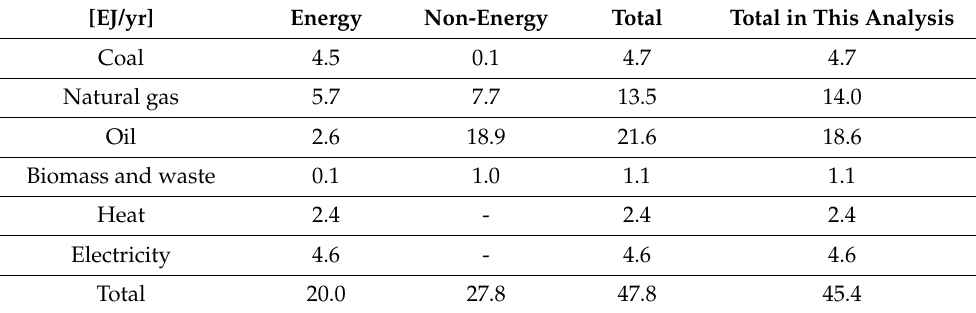
Table 1. Global energy and non-energy use for petrochemical production according to the energy statistics, 2017. [EJ/yr] Energy Non-Energy Total Total in This Analysis Coal